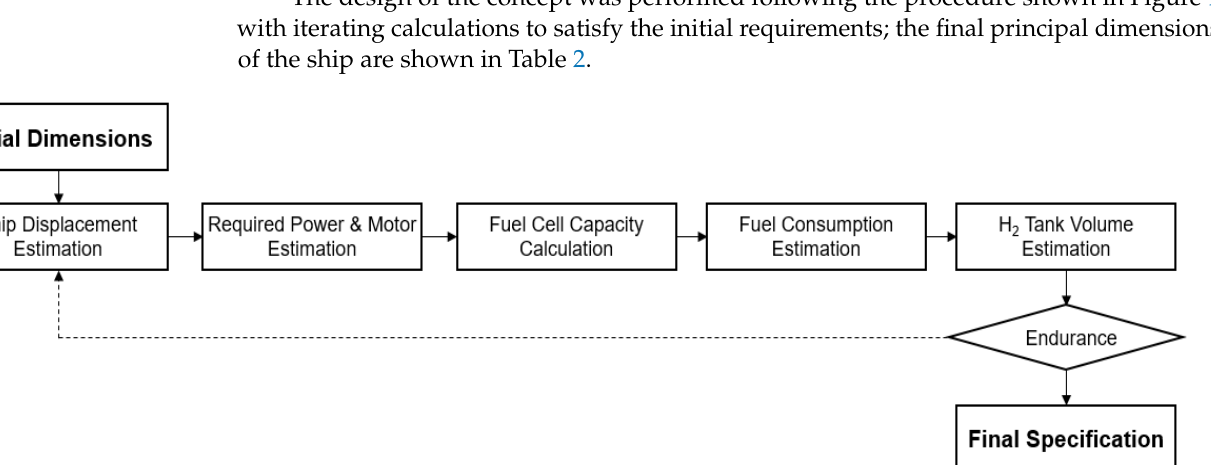
Figure 8. Energy source fractions of electricity in the Republic of Korea [31].